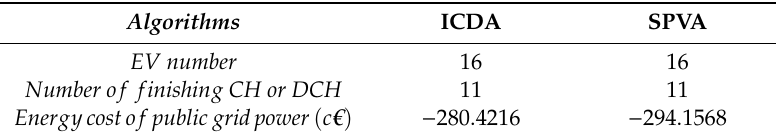
Table 6. Results comparison of ICDA and